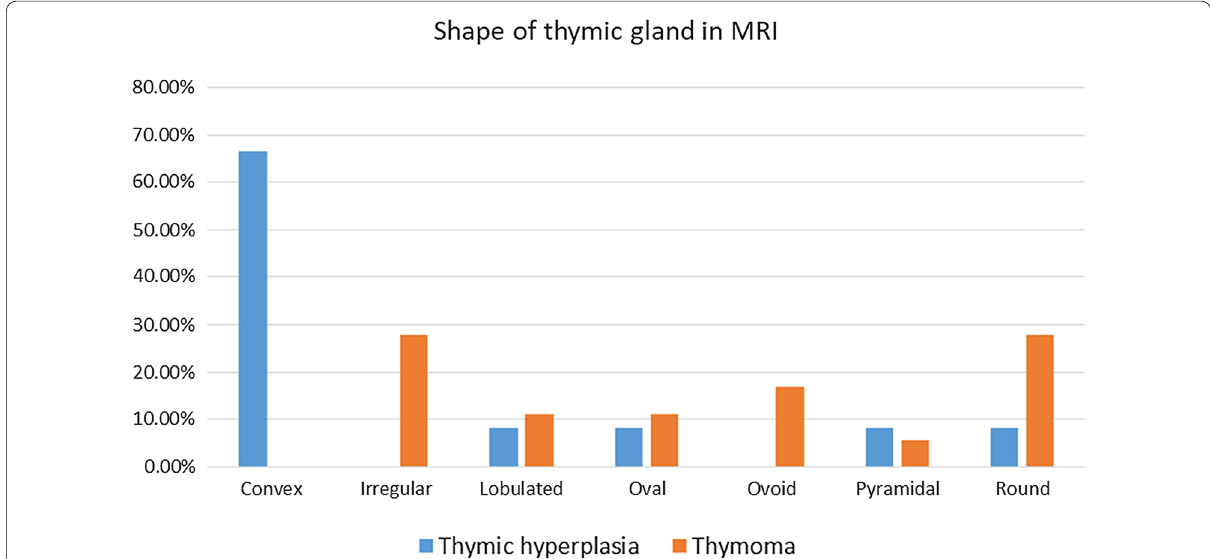
Fig. 2 Bar chart showing shape of thymic gland by MRI based on histopathology findings